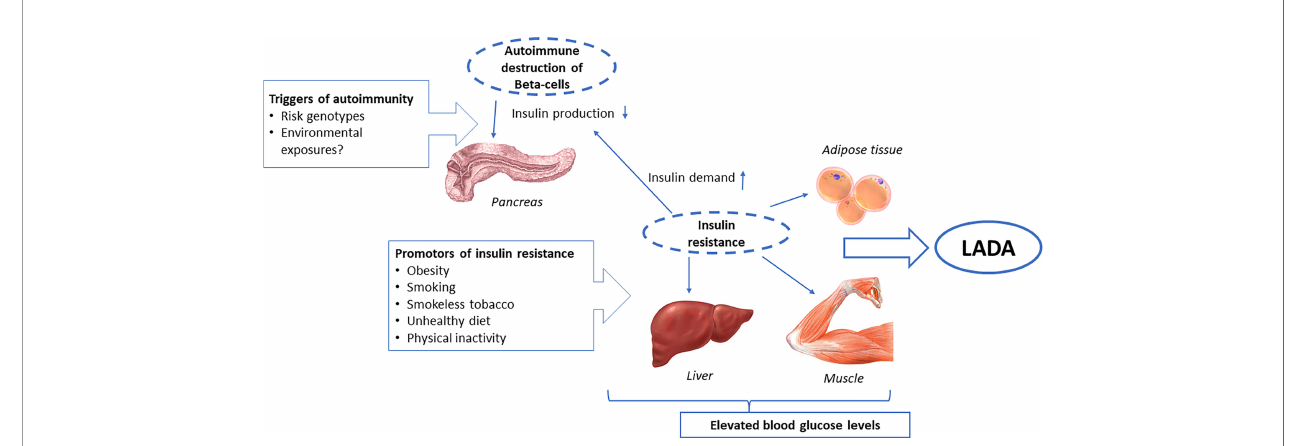
FIGURE 4 | Etiology of